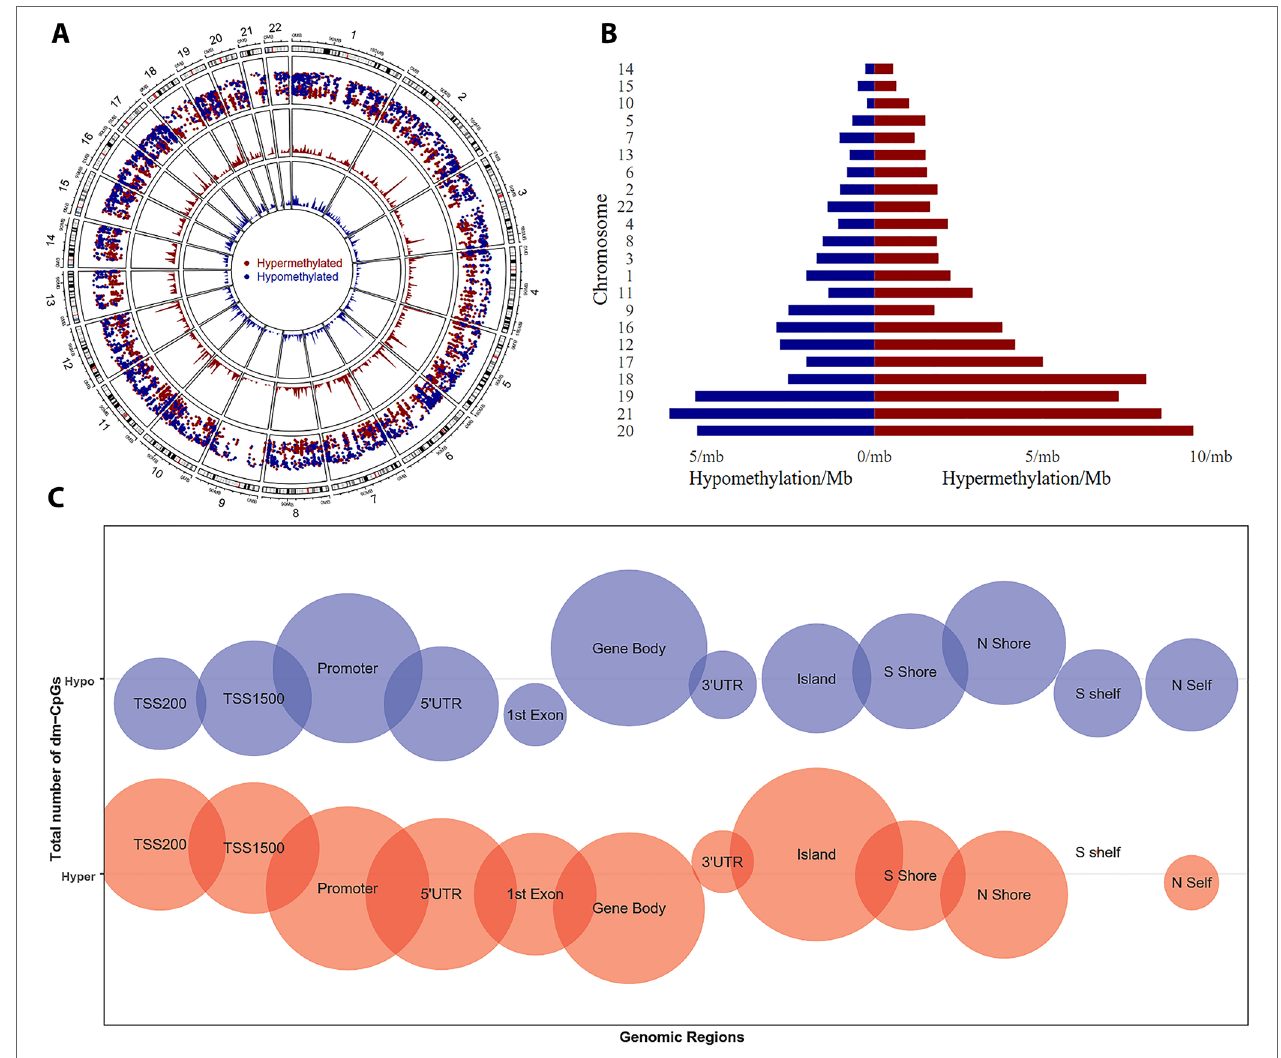
FIGURE 1 | Differential DNA methylation distribution. (A) Circular plot of CpGs, chromosomes are shown in a clockwise direction from 1 to 22 in the outermost circle. Chromosomes X, Y, and M were excluded from analysis. The two innermost circles represent the differential hypermethylation and hypomethylation frequencies in a 10 Mb sliding window across the genome. (B) Pyramid (stacked) plot for differential hyper and hypomethylation frequencies for each chromosome. Chromosomes are sorted based on total differential methylation in per megabase pair length of the chromosomes. (C) Bubble plot of differentially methylated CpGs in genomic regions. Size of bubble represents a total number of